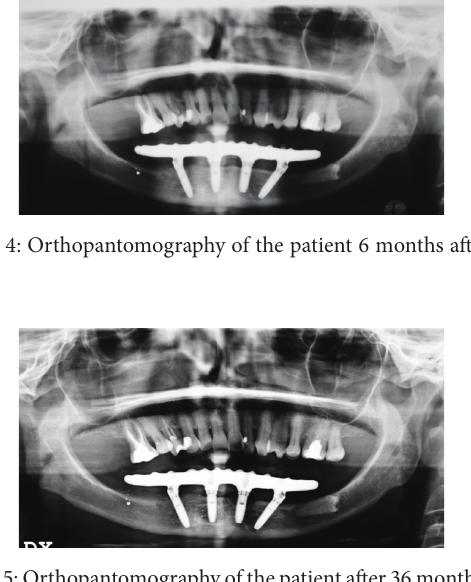
Figure 5: Orthopantomography of the patient after 36 months from surgery.